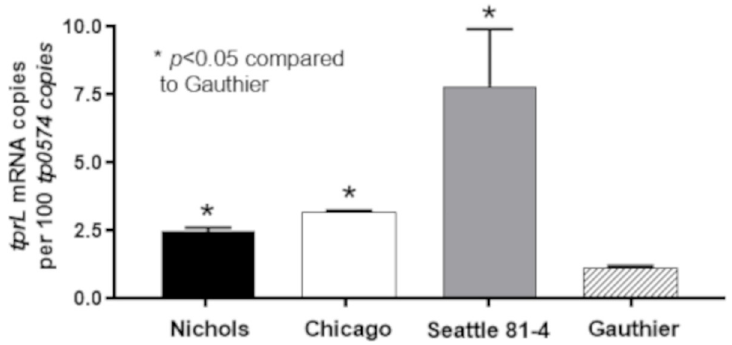
Fig 1. tprL mRNA levels normalized to the tp0574 message in the T . p . pallidum Nichols, Chicago and Seattle 81–4 strains and in the in the T . p . pertenue Gauthier strain harvested at peak orchitis post-IT inoculation. Asterisk ( � ) indicates a significant difference ( p < 0.05) compared to the Gauthier